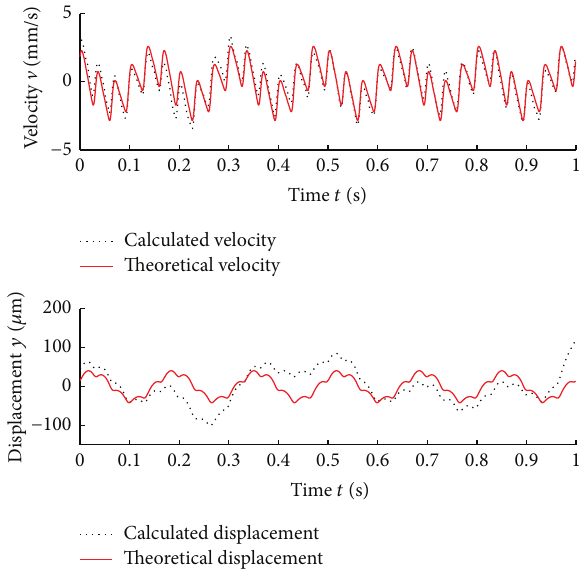
Figure3:ComparisonoftheTDIresultswiththetheoreticalsignals.